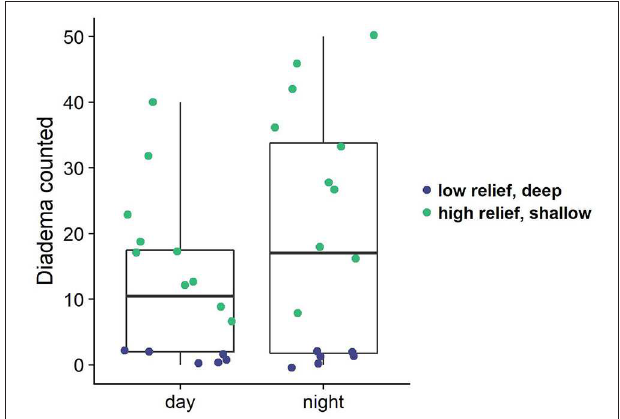
FIGURE 8 | Diadema counts from paired day/night transects. Colored dots indicate the depth zone of the survey (shallow: ≤ 11m, deep: 12–17m), which also correspond to structural complexity in this case (shallow = high relief; deep = low